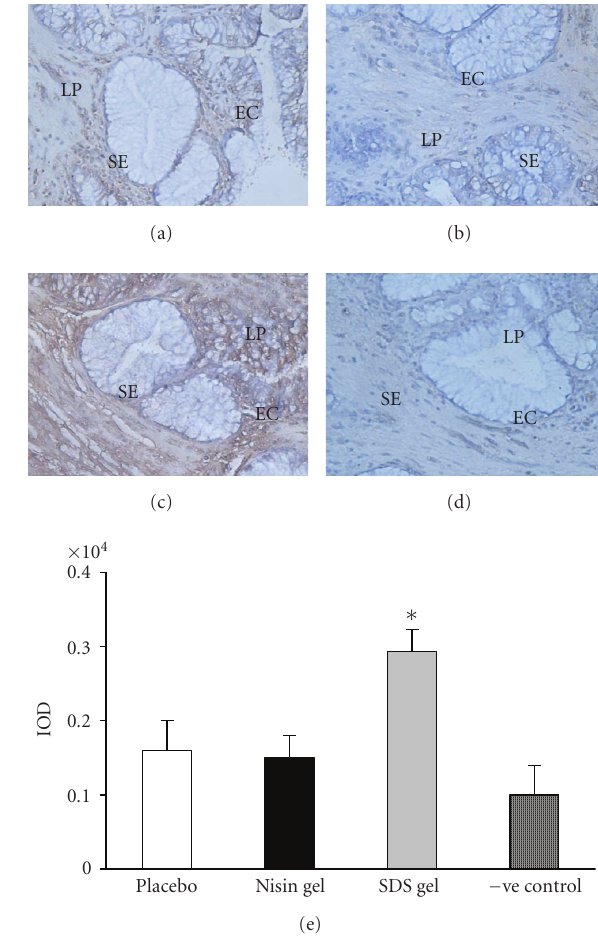
Figure 6: Immunohistochemical localization of IL-10 in the CVE after intravaginal application of nisin gel (15.15 mM in 2mL of 1% polycarbophil gel) (b), SDS (56 μ M in 2mL of 1% polycarbophil gel) (c) and 2 mL of 1% polycarbophil gel for 14 consecutive days. To rule out the nonspecific binding, sections were incubated in preimmune sera instead of primary antibody and considered as negative control (d). Semiquantitative comparison by measuring integrated optical density (IOD) of immunoreactive IL-10 in treated and placebo is shown (e). The IOD in each area was then measured for the brown color immunoprecipitates. Each value is the mean ± SD of six observations obtained from three independent samples. Figure shown is representative picture from three independent experiments. (Mag X 20) (EC = epithelial cells, SE = squamous epithelium, LP = lamina propria), ( ∗ = values are statistically significant at P < . 05).